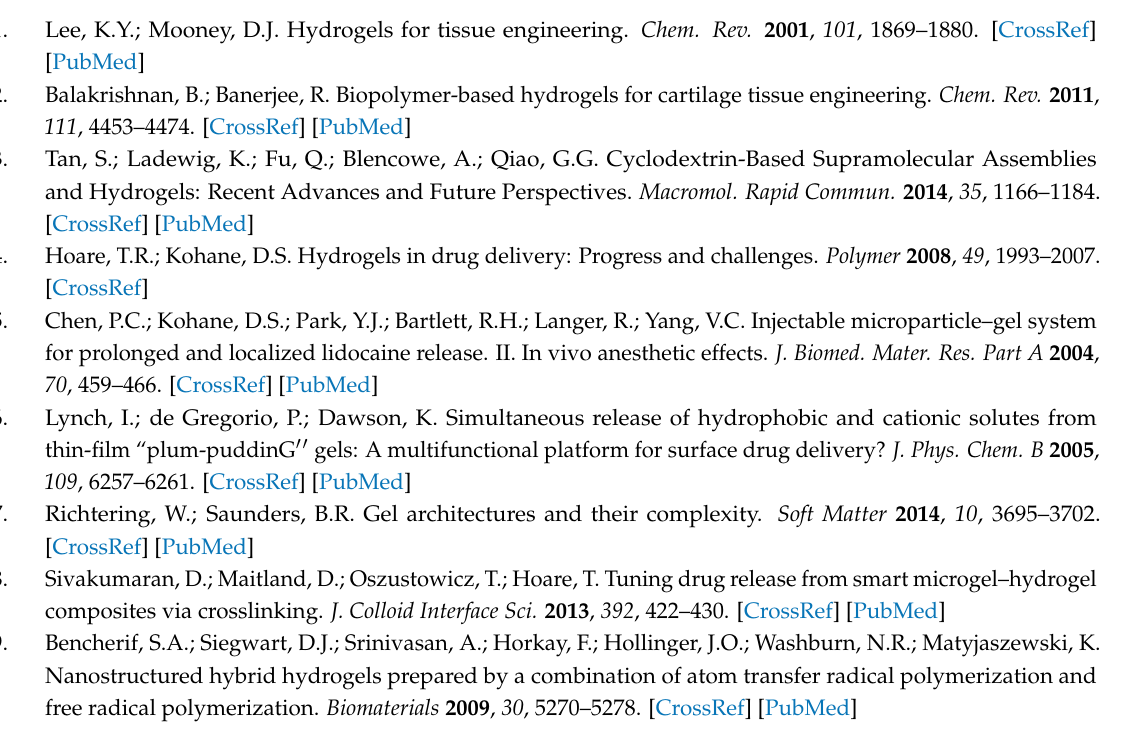
Figure S1: Schematic structure of β -cyclodextrin and adamantyl moieties. Figure S2: Hydrodynamic diameter as a function of temperature for positively overcharged microgels. Figure S3: Frequency sweep data of G3 fitted with a generalized Maxwell model. Figure S4: Oscillatory rheological measurements of G5